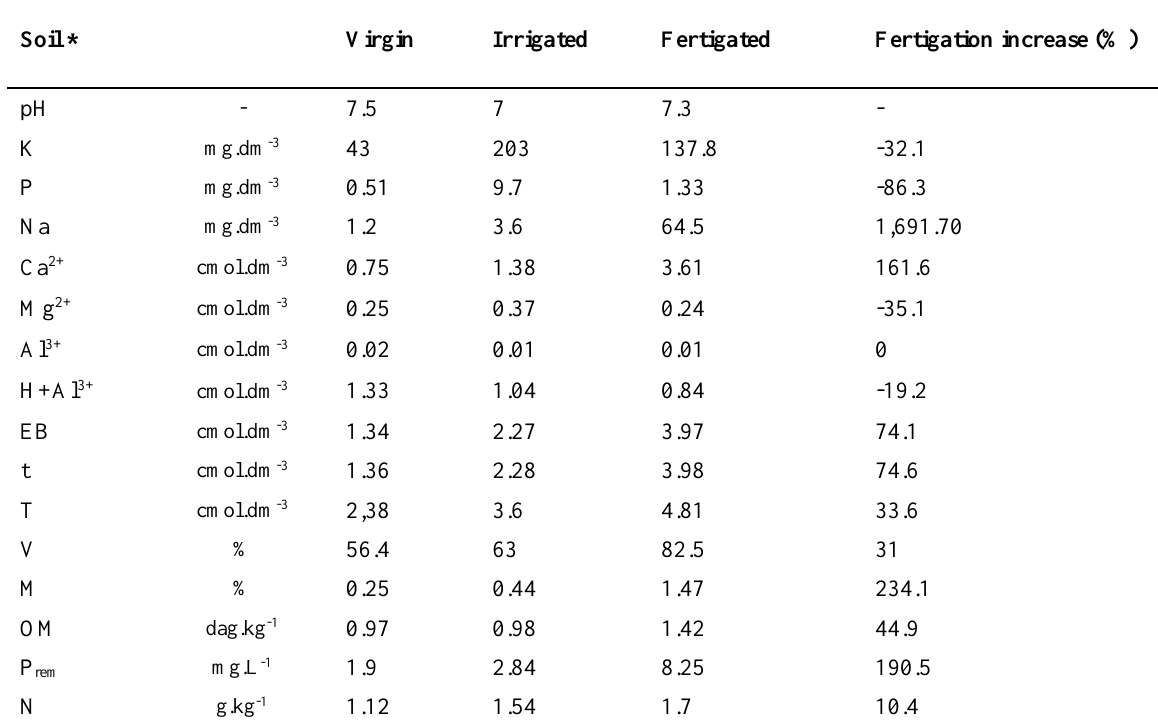
Table 4 Results of chemical analyses of soil (0-20 cm) before and after irrigation and fertigation with WWTP-UFLA